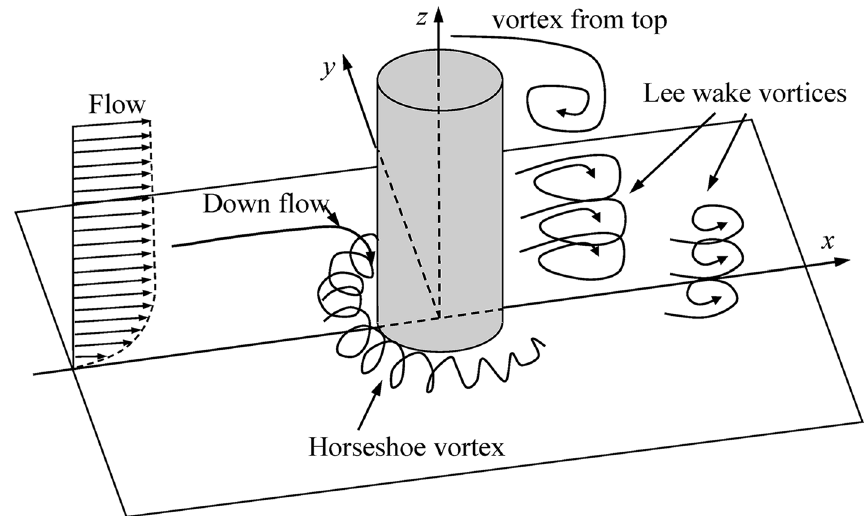
Fig. 2 Scouring process on bridge pier. Figure adapted from Reference (Zhao 2022) with permission from